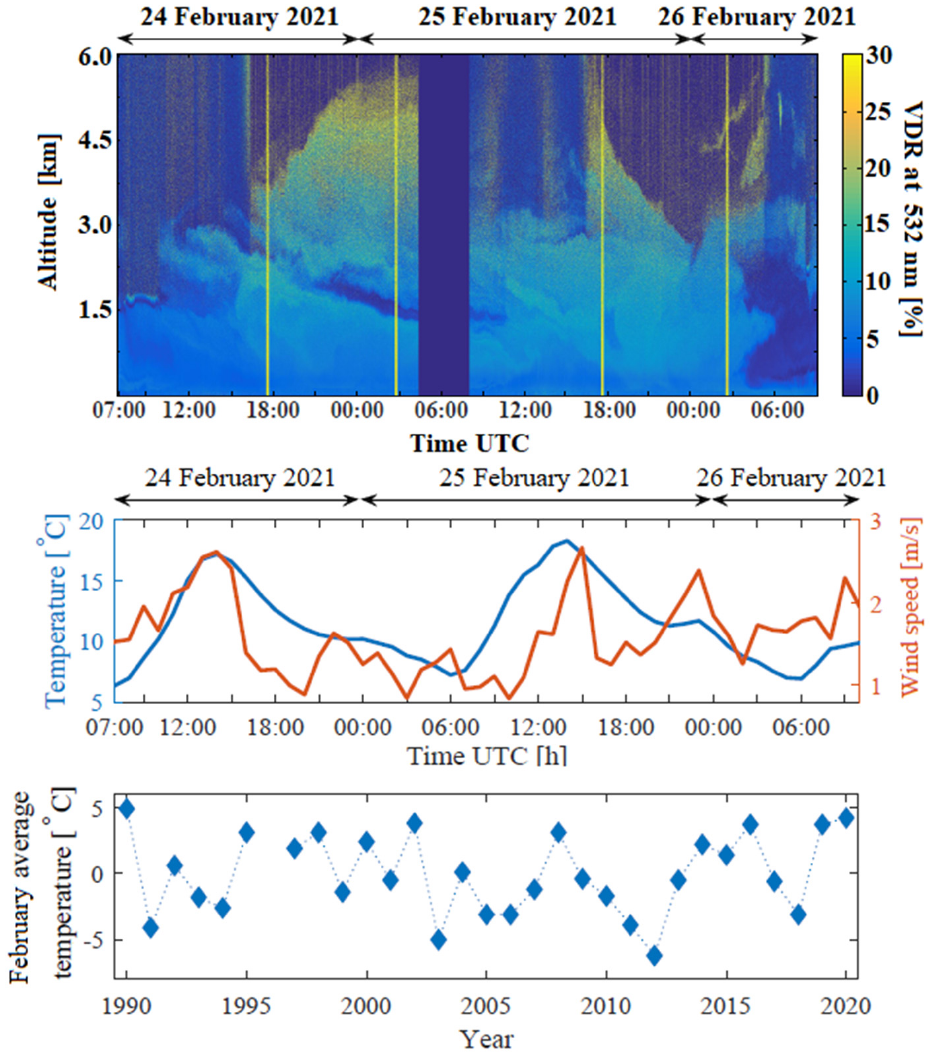
Figure 2. Volume Depolarization Ratio (VDR, upper panel) at 532 nm from Polly XT lidar measure- ments, as well as diurnal cycles of air temperature and wind speed (blue and orange lines, middle panel) at the EARLINET-ACTRIS station in Warsaw between 24-26 February 2021. The lowest panel depicts the February average temperature for the years 1990-2020. Yellow strips denote times of depolarization calibration, while dark blue indicates a lack of data due to technical issues. Table 1. SCC settings for Polly XT lidar system for particular optical products retrieval.